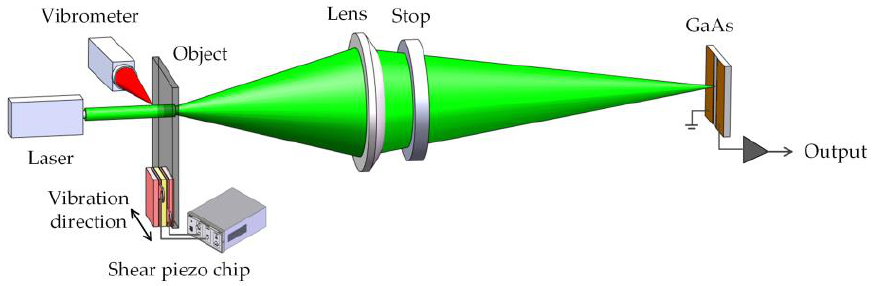
Figure 3. Schematic of experimental system.